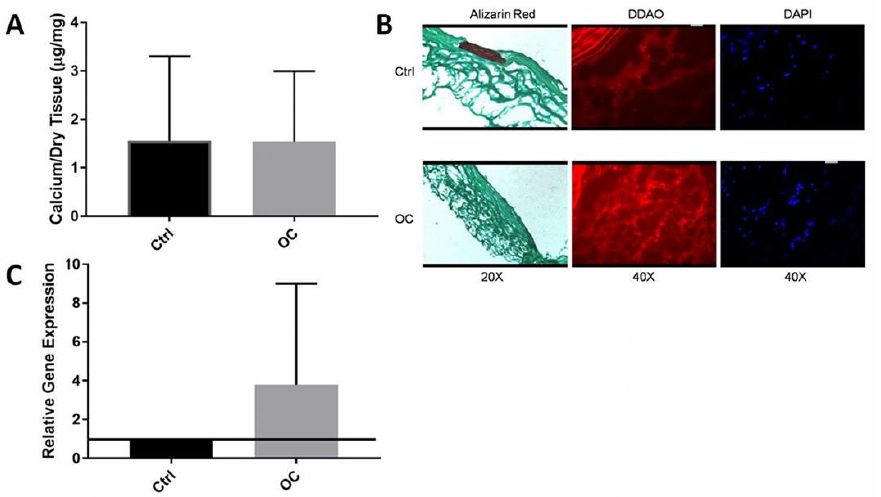
Figure 5. ( A ) Locally delivered OCs did not reduce calcification, as shown in the calcium per dry weight graph, with no difference between controls and OCs ( n = 5). ( B ) Histological analysis shows the calcification (Alizarin Red) is isolated to the medial layer and although OCs were successfully delivered, they are only in the adventitial layer and did not migrate to the site of calcification ( C ) Gene analysis of Cat-K confirms successful delivery of OCs, with OCs expressing Cat-K at a rate four-fold higher than the control group ( n = 4). Data were analyzed with ANOVA and Student’s t -test, with p < 0.05. No statistical differences were observed.